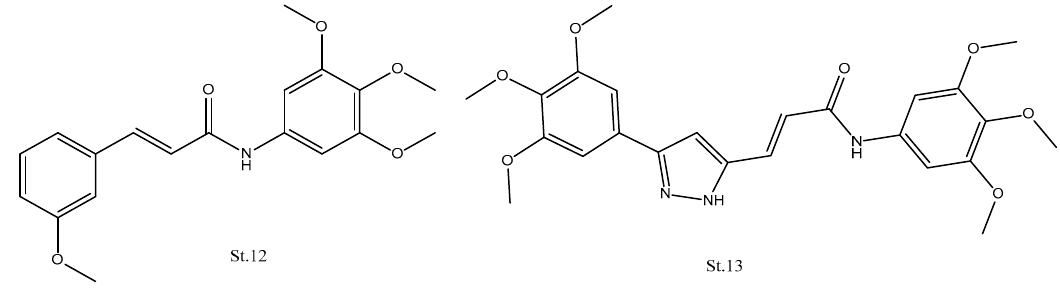
Figure 5. The structures of CA-4 analogues phenyl cinnamides and arylcinnamides.